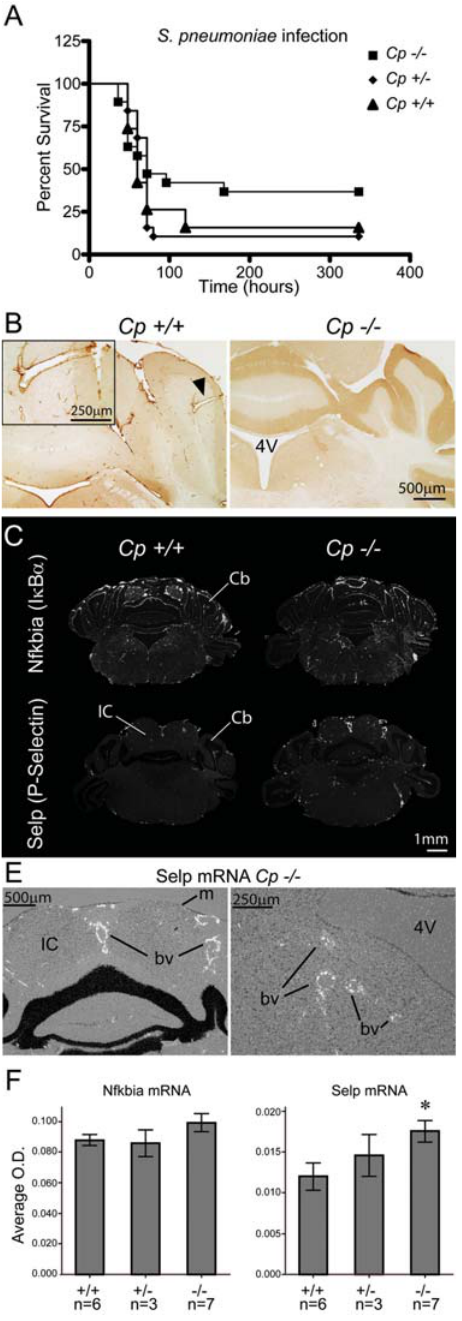
Figure 7. Modulation of cerebro-vascular response by ceruloplasmin during early phases of pneumococcal infection. (A) Survival curves of Cp + / + , + /- and -/- following inoculation with S. Penumoniae (2 week follow up). (B) Ceruloplasmin protein immunoreactivity at the vascular level in the hindbrain of a Cp + / + infected mouse; Cp -/- mice was used as control for the primary antibody. (C) Dark-field photomicrographs showing representative hybridization signals of Nfkbia or Selp ribop- robes on hindbrain sections of Cp + / + or -/- mice killed at the early phase of infection (36–48 h post-infection). (D) High magnification photo- micrographs depicting the expression pattern of Selp mRNA associated with large blood vessels and not in cells lining the meninges or the ventricle. (E) Semi-quantitative analysis of Nfkbia and Selp mRNA levels O.D. Student’s t-test was used to compare Cp + / + and Cp -/- means (see text for details); * p , 0.05. Abbreviations: bv, blood vessel; Cb, cerebellum; IC, inferior colliculus; m, meninges.